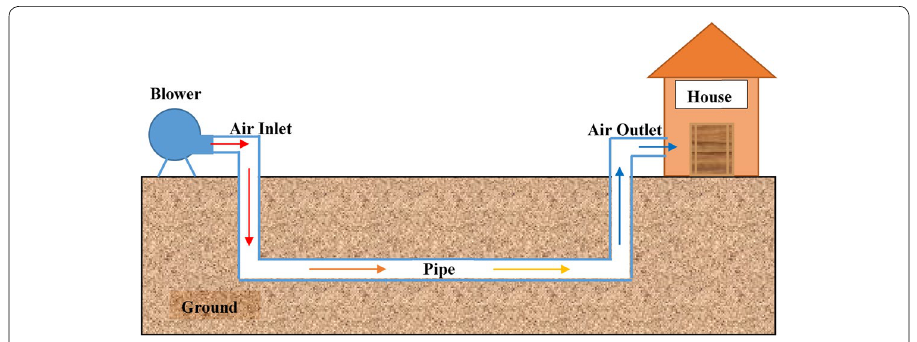
Fig. 1 Working principle of EATHE